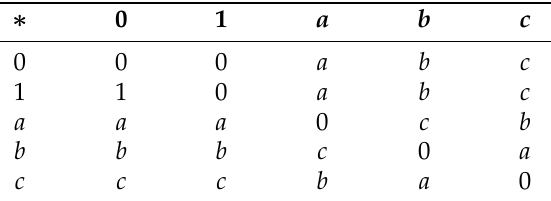
Table 8. Cayley table for the binary operation “ ∗ ”.